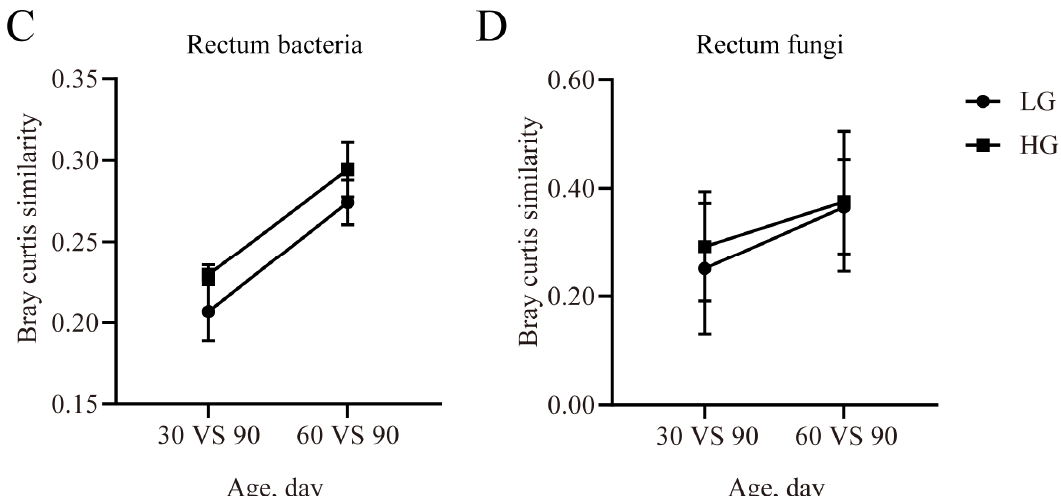
Figure 5. The similarity of the microbial community at different timepoints with Bray–Curtis matrix. The similarity of bacterial community between the timepoints and the 90-day-old lambs in the rumen ( A ) and rectum ( B ). The similarity of the fungal community between the timepoints and the 90-day-old lambs in the rumen ( C ) and rectum ( D ). Data are expressed as mean ± SE. ** p < 0.05. LG: lambs with the lower average daily gain; HG: lambs with the higher average daily gain.